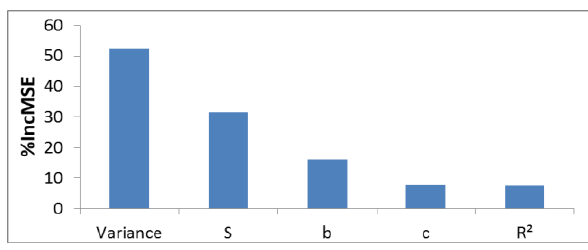
Figure 8: Metrics’ order of importance in the RF classifier Figure 8. Metrics’ order of importance in the RF